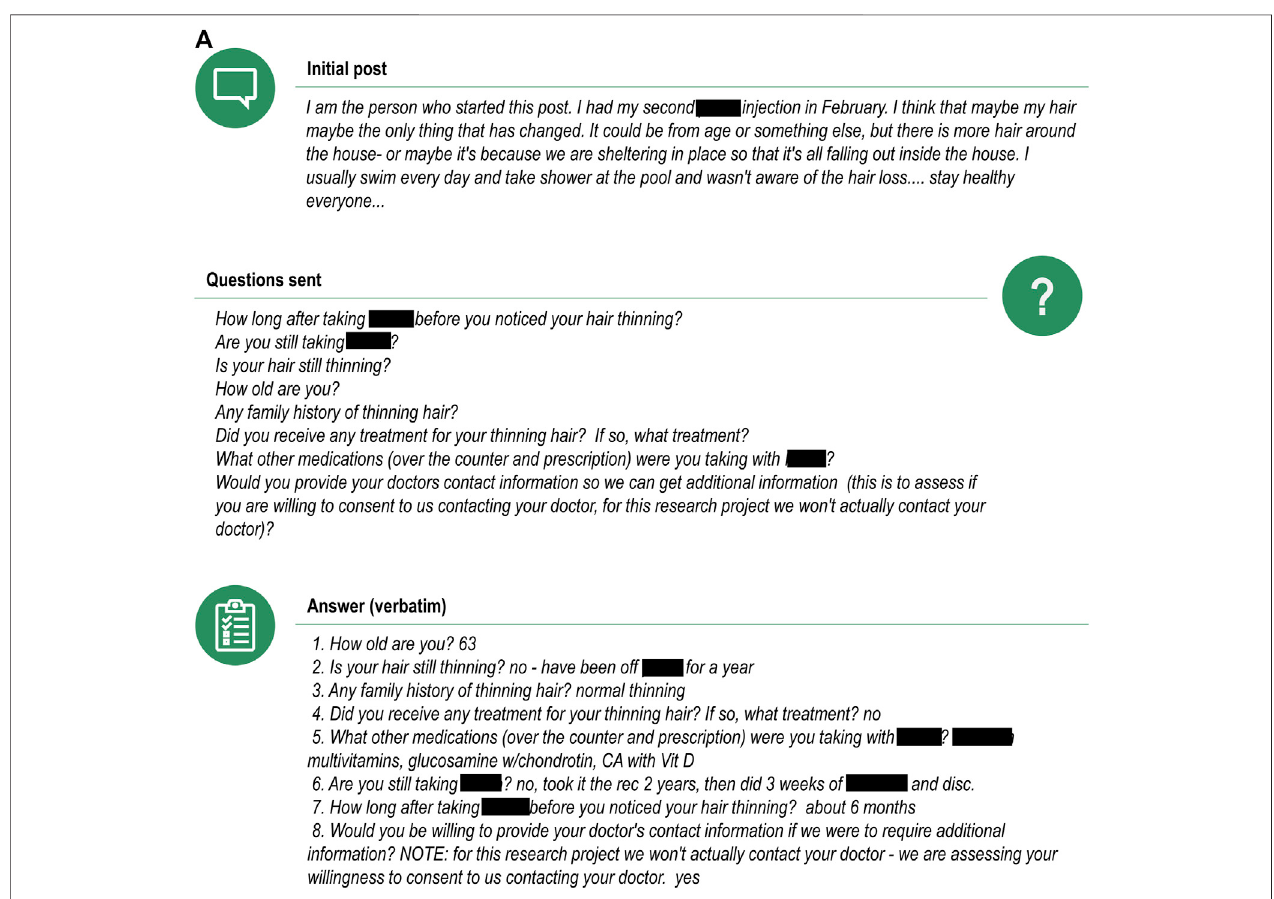
FIGURE7| Examples ofanassessable (A) and non-assessable (B) caseafter follow-upinformation wasrequested and provided bythepatient.Note: The drugof interest was denosumab. Posts are listed verbatim but mentions to trade names of drugs or sensitive personal information have been redacted.